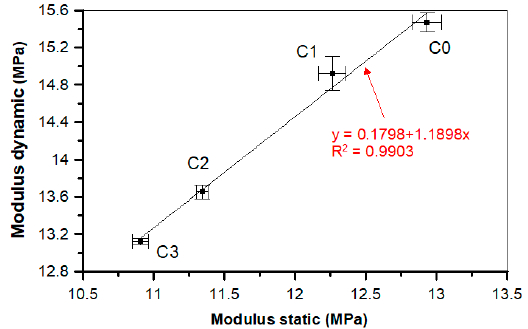
Figure 21. Correlation between the static and dynamic moduli of a concrete.